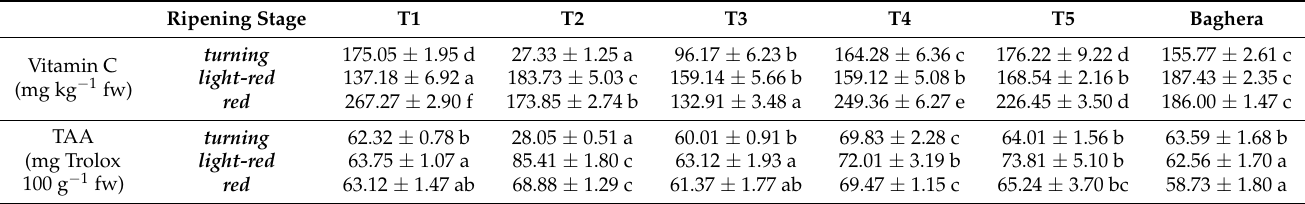
Table 4. Vitamin C concentration and total antioxidant activity in